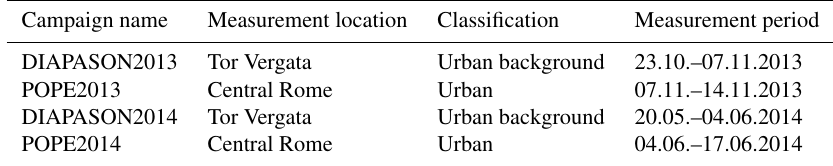
Table 1. Summary of measurement campaigns and measurement periods. Date format is dd.mm.yyyy.